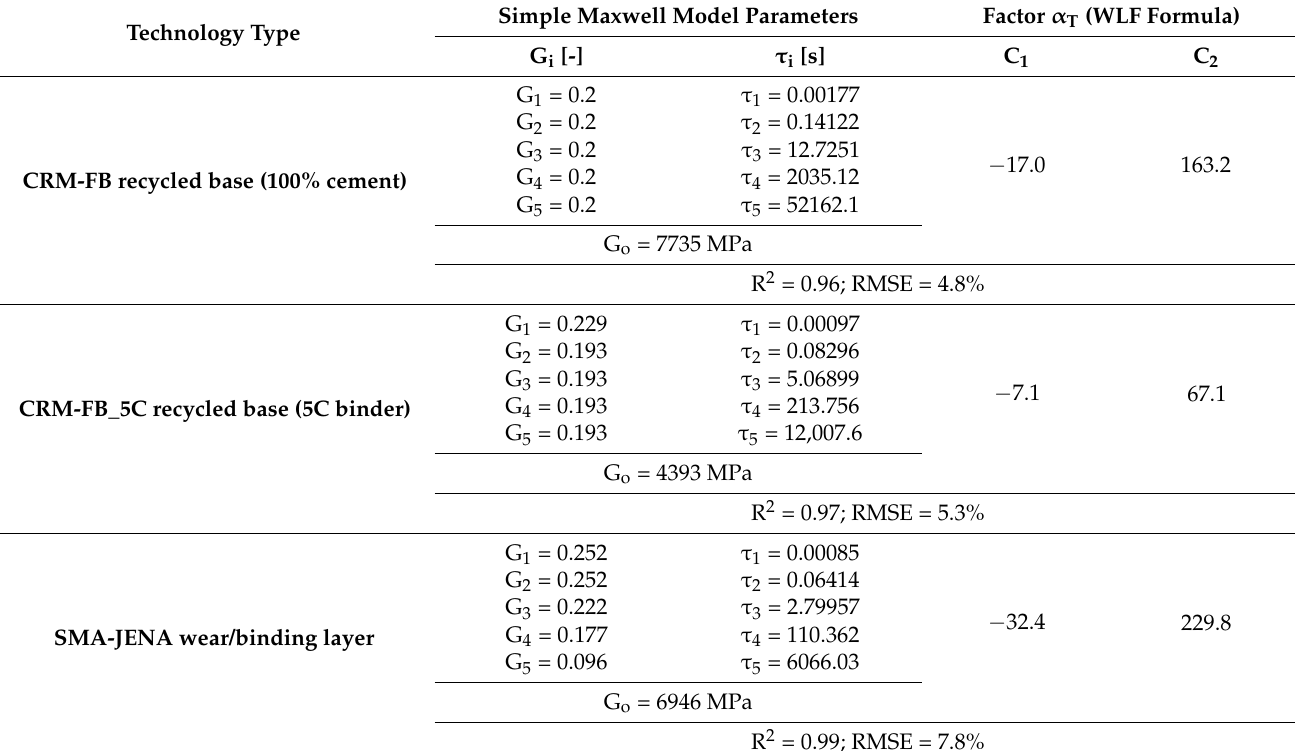
Table 7. Master curve parameters of SMA-JENA and CRM-FB on the basis of generalised Maxwell model (GM) at a reference temperature of 13 ◦